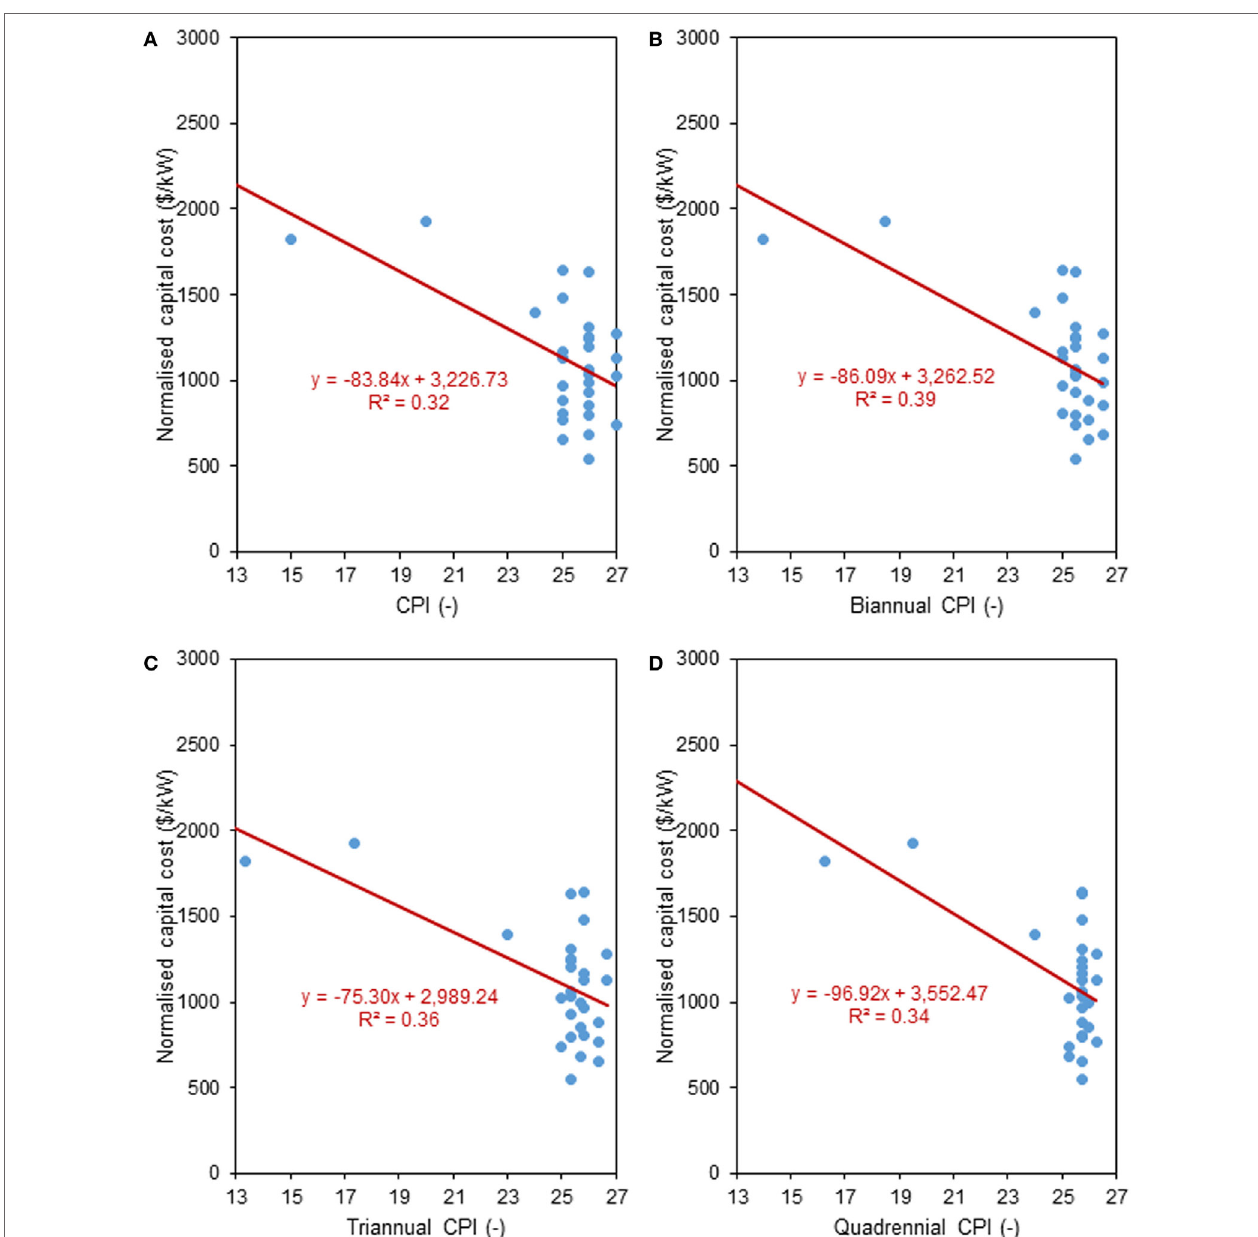
FigUre 7 | Corruption vs. capital cost analysis for Bangladeshi power plants: (a) normalized capital cost vs. average annual Corruption Perceptions Index (CPI) scores, (B) normalized capital cost vs. average biannual CPI scores, (C) normalized capital cost vs. average triannual CPI scores, and (d) normalized capital cost vs. average quadrennial CPI